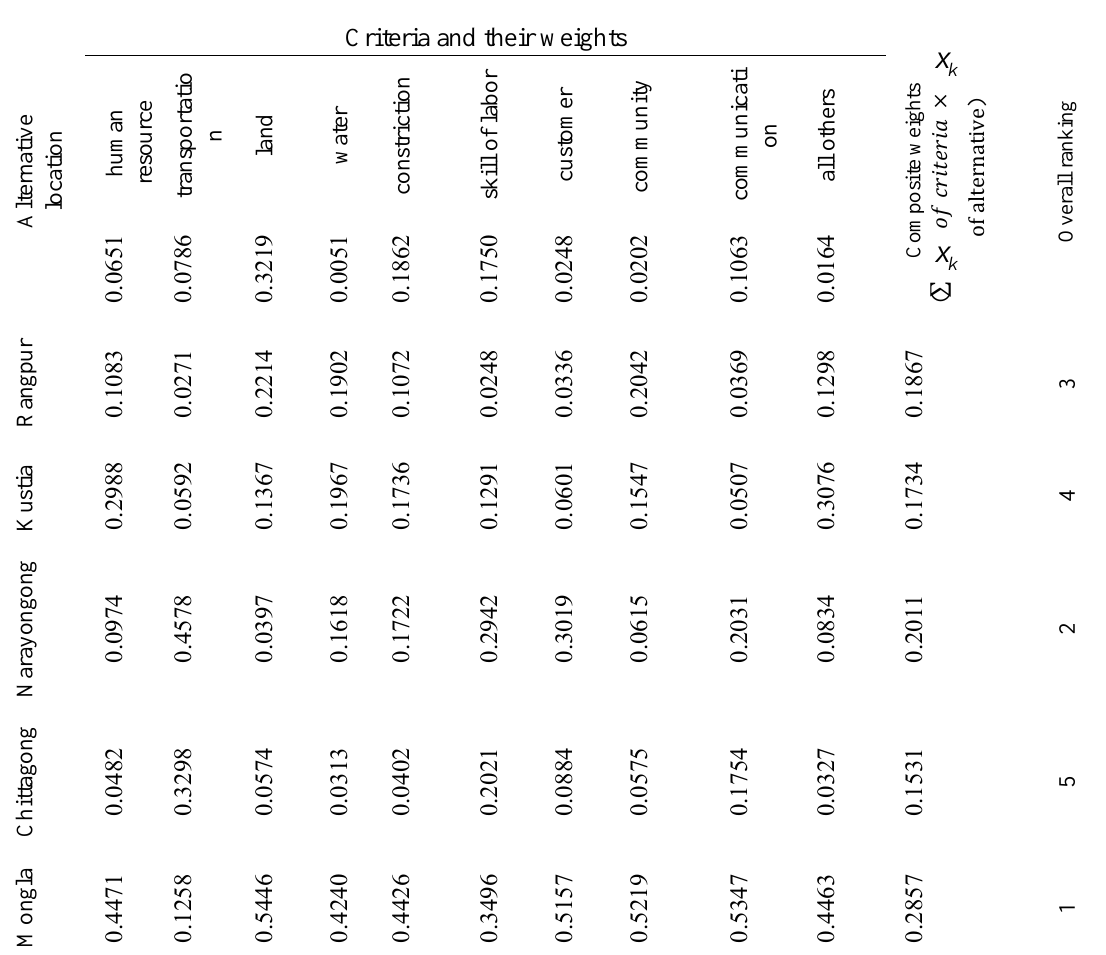
Table 15. Evaluation of